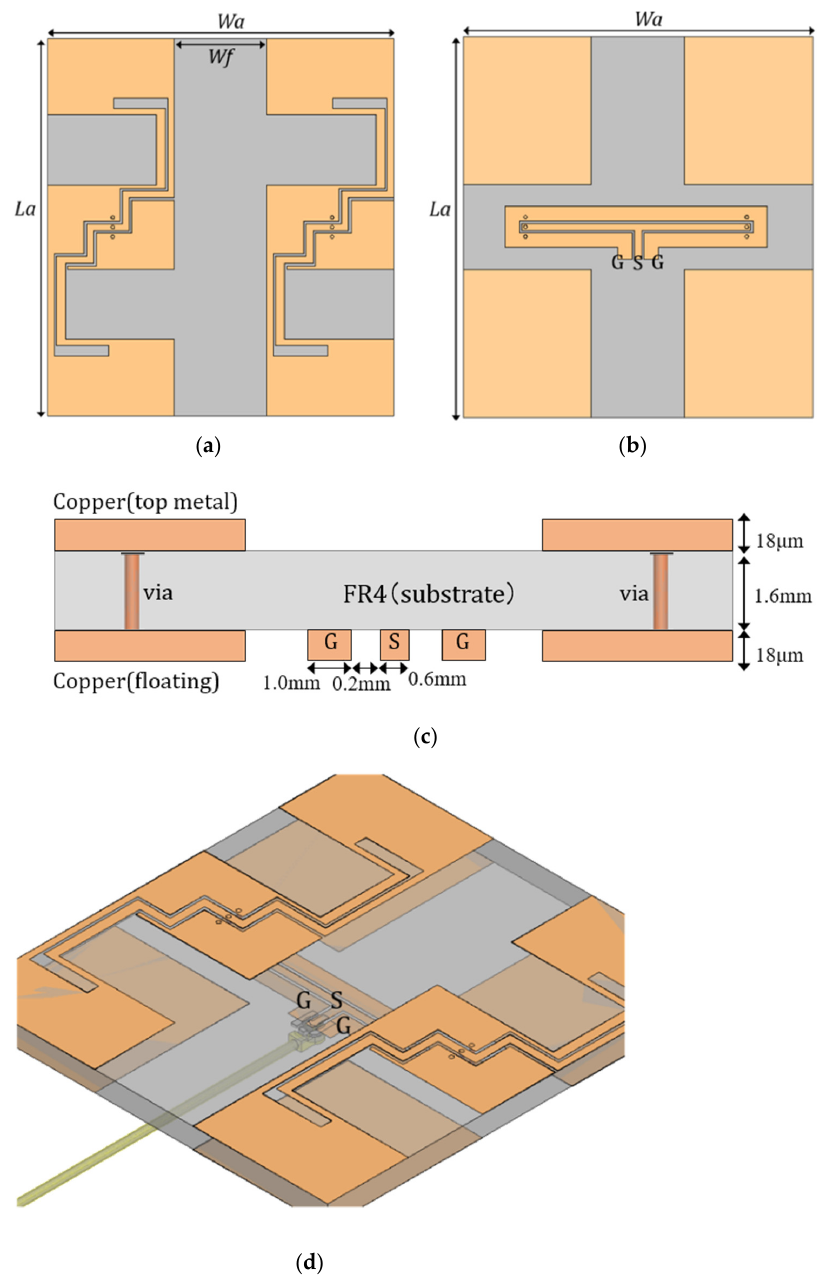
Figure 9. Structure of 2 × 2 array antenna: ( a ) front structure, ( b ) back structure, ( c ) cross-sectional structure, and ( d ) connector section.